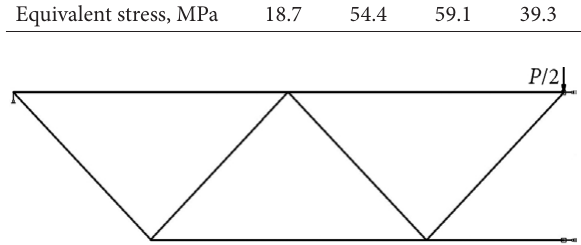
Table 3. H-M equivalent stress values Location (β-β)